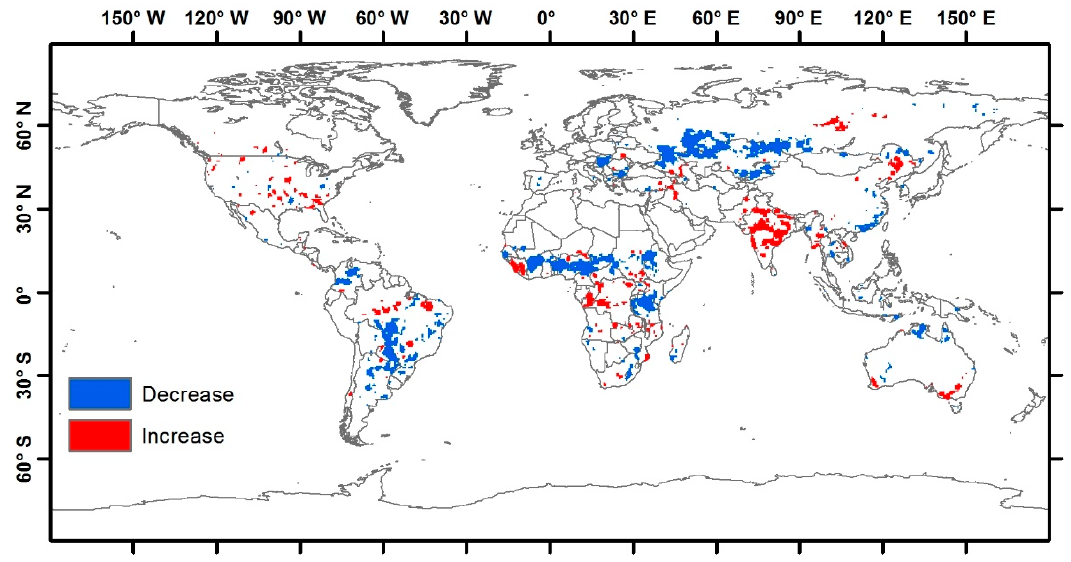
Figure 5. Significant trends of BA in the short-term series (2001–2018) for the high-resolution BA product (FireCCI51), selecting a confidence level of 95%.